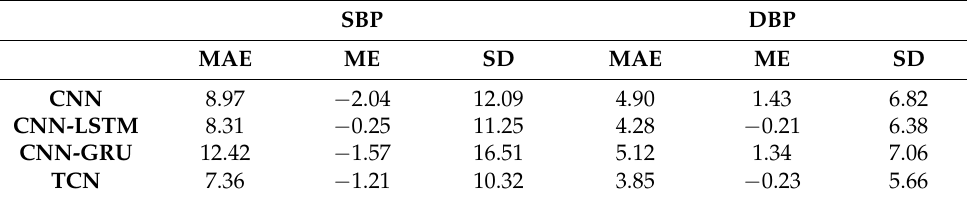
Table 2. Results and comparison of each model.